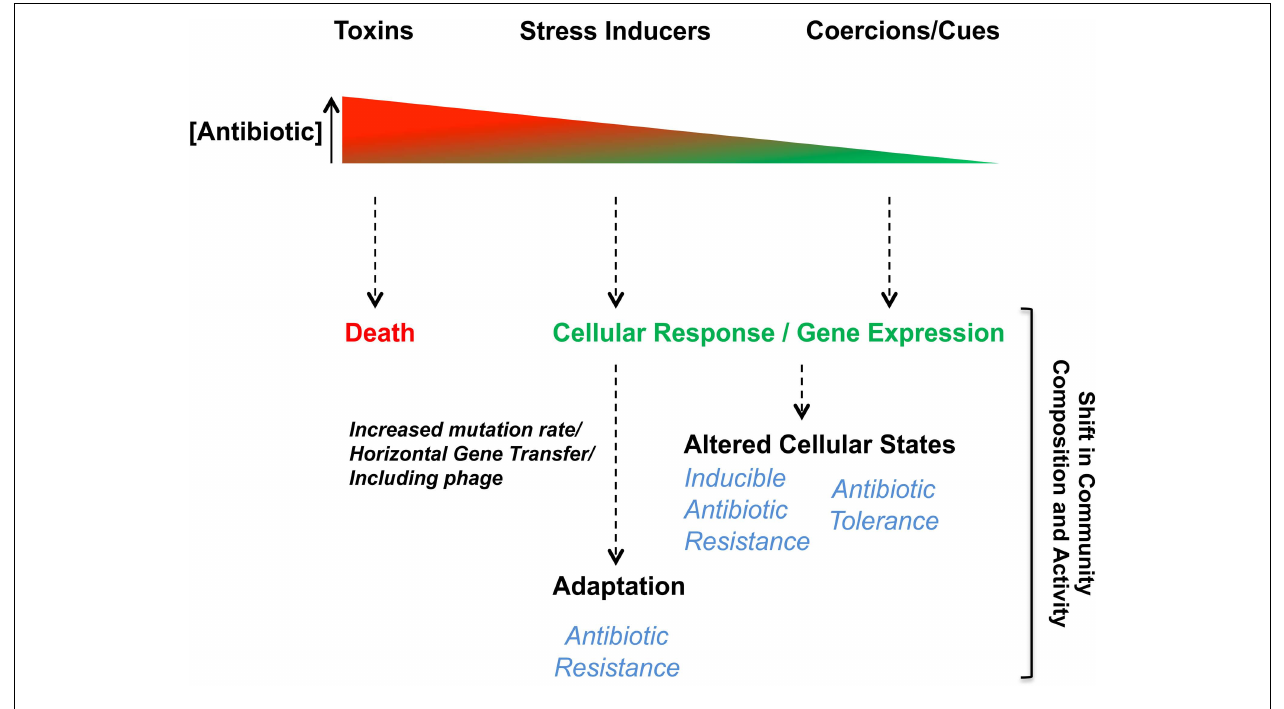
FIGURE 2 | Biological responses toward antibiotics are concentration- dependent. Bacterial interactions mediated by antibiotics induce biological responses in receiver bacteria in a dose-dependent manner.The antimicrobial behavior (toxin) of antibiotics occurs when their concentrations is high leading to bacterial death or growth arrest in susceptible receiver cells. At lower